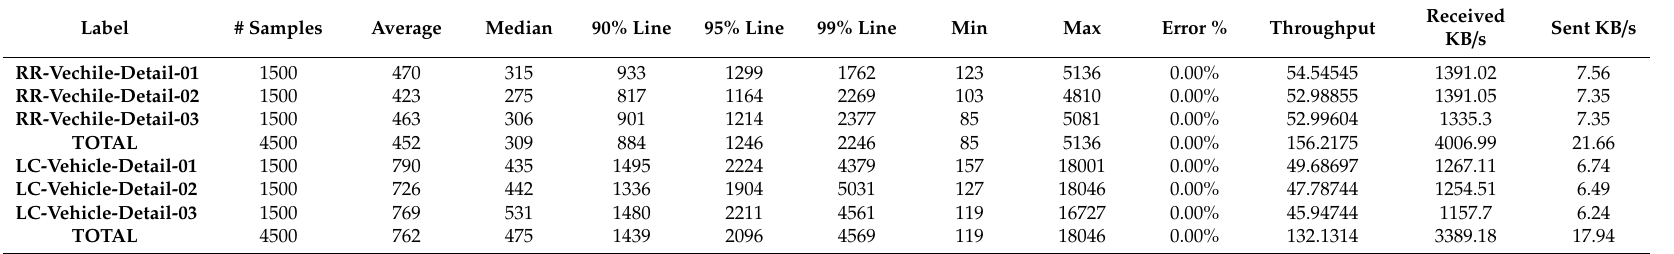
Table 6. Statistics table of the round robin algorithm and least connection algorithm of the third load